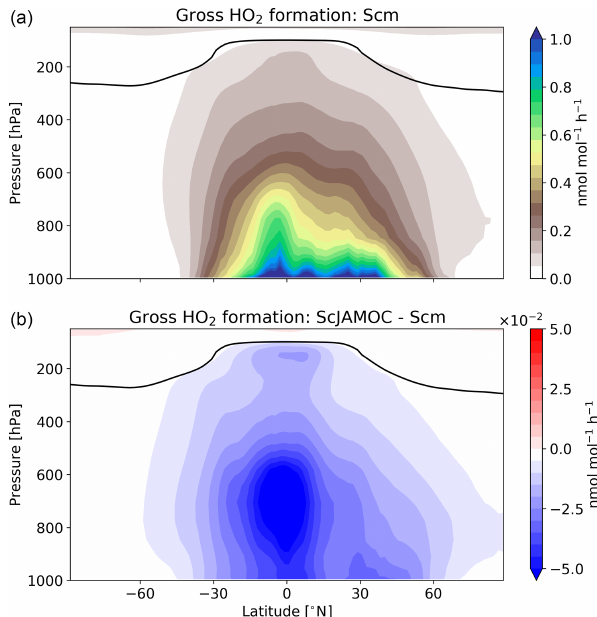
Figure 6. Zonal-mean gross OH formation for Scm (a) and in com- parison to ScJAMOC (b) . The characteristics of each simulation are provided in Table 1. The yearly mean tropopause is depicted by a black line.